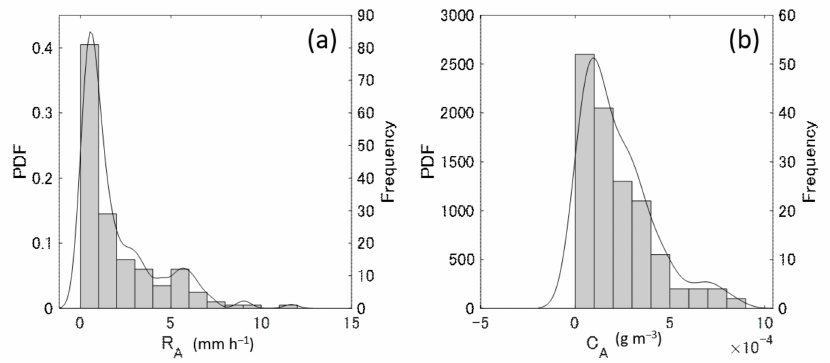
Figure 13. The same as Figure 8, but for integrated PSD parameters including ( a ) R A and ( b ) C A